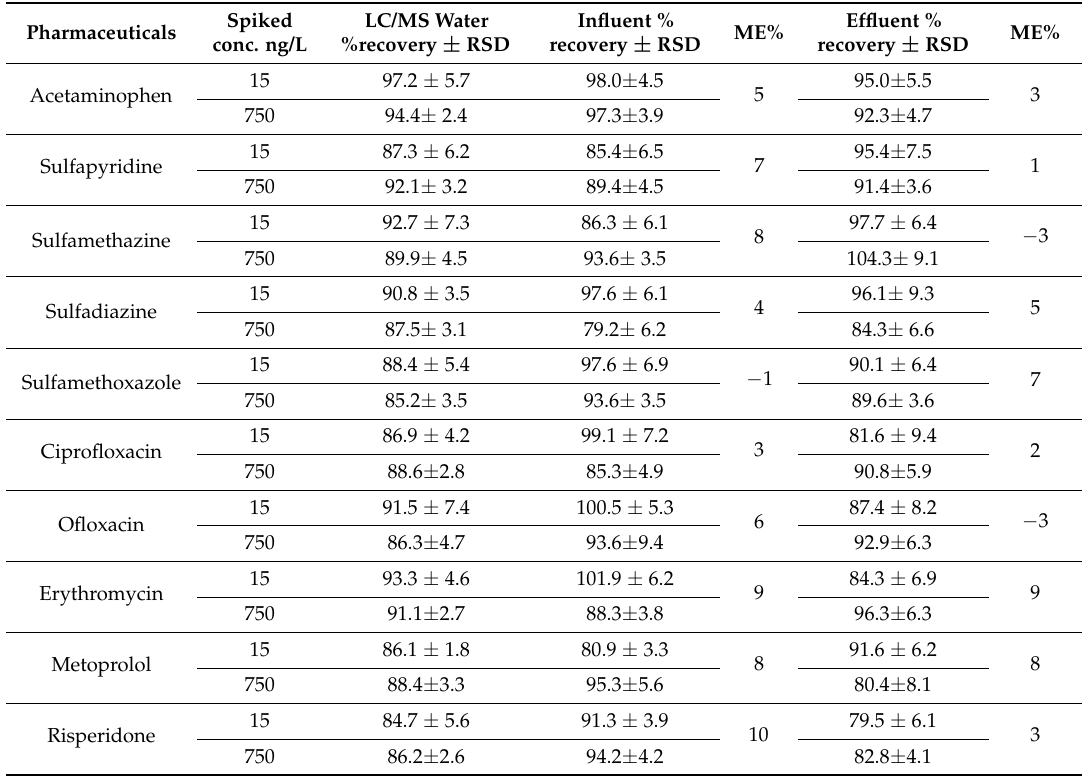
Table 3. Percentage recoveries (n = 3) and matrix effect of spiked LC-MS water, influent and effluent wastewater samples at two different concentration levels (15 and 750 ng/L).